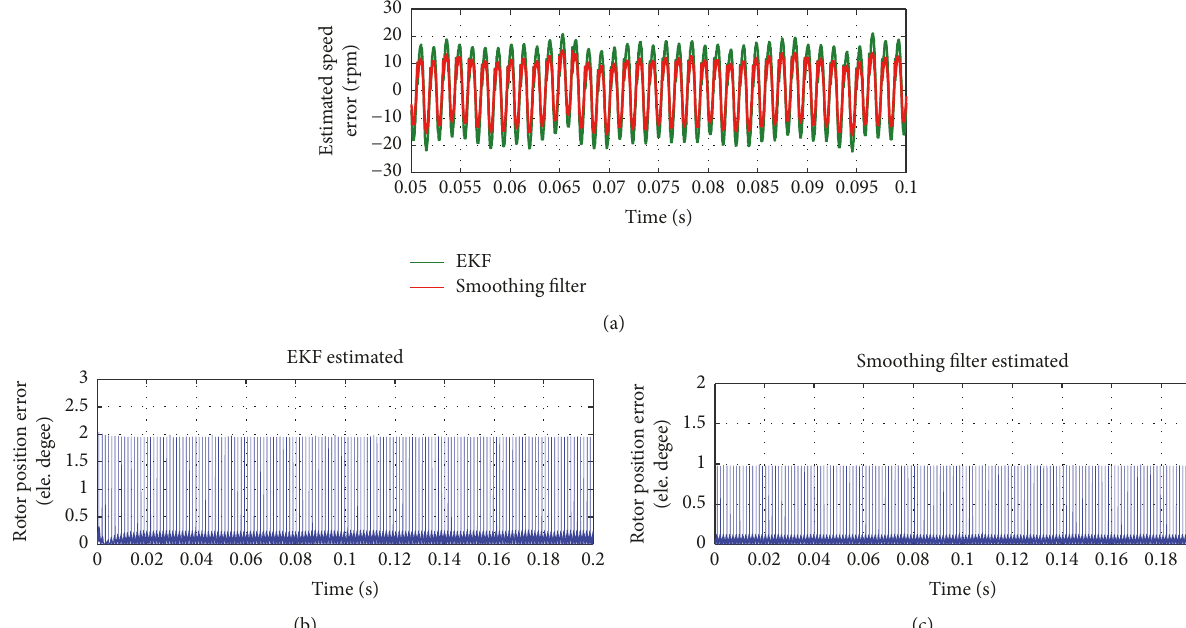
Figure 7: (a) Speed estimation error at half rated torque. (b) Position estimation error with EKF. (c) Position estimation error with smoothing filter.